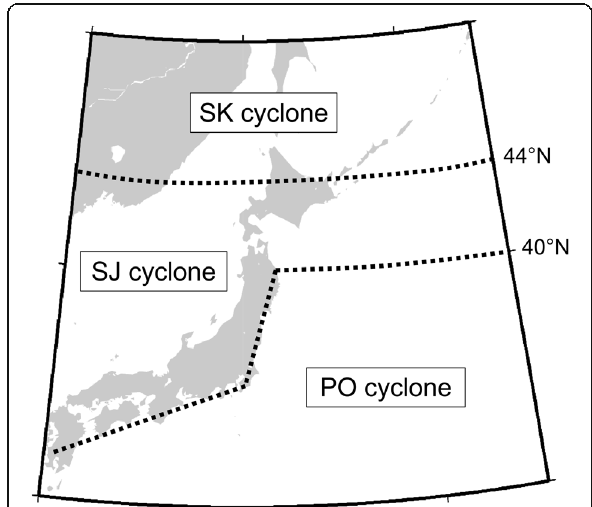
Fig. 8 Definitions of SK , SJ , and PO